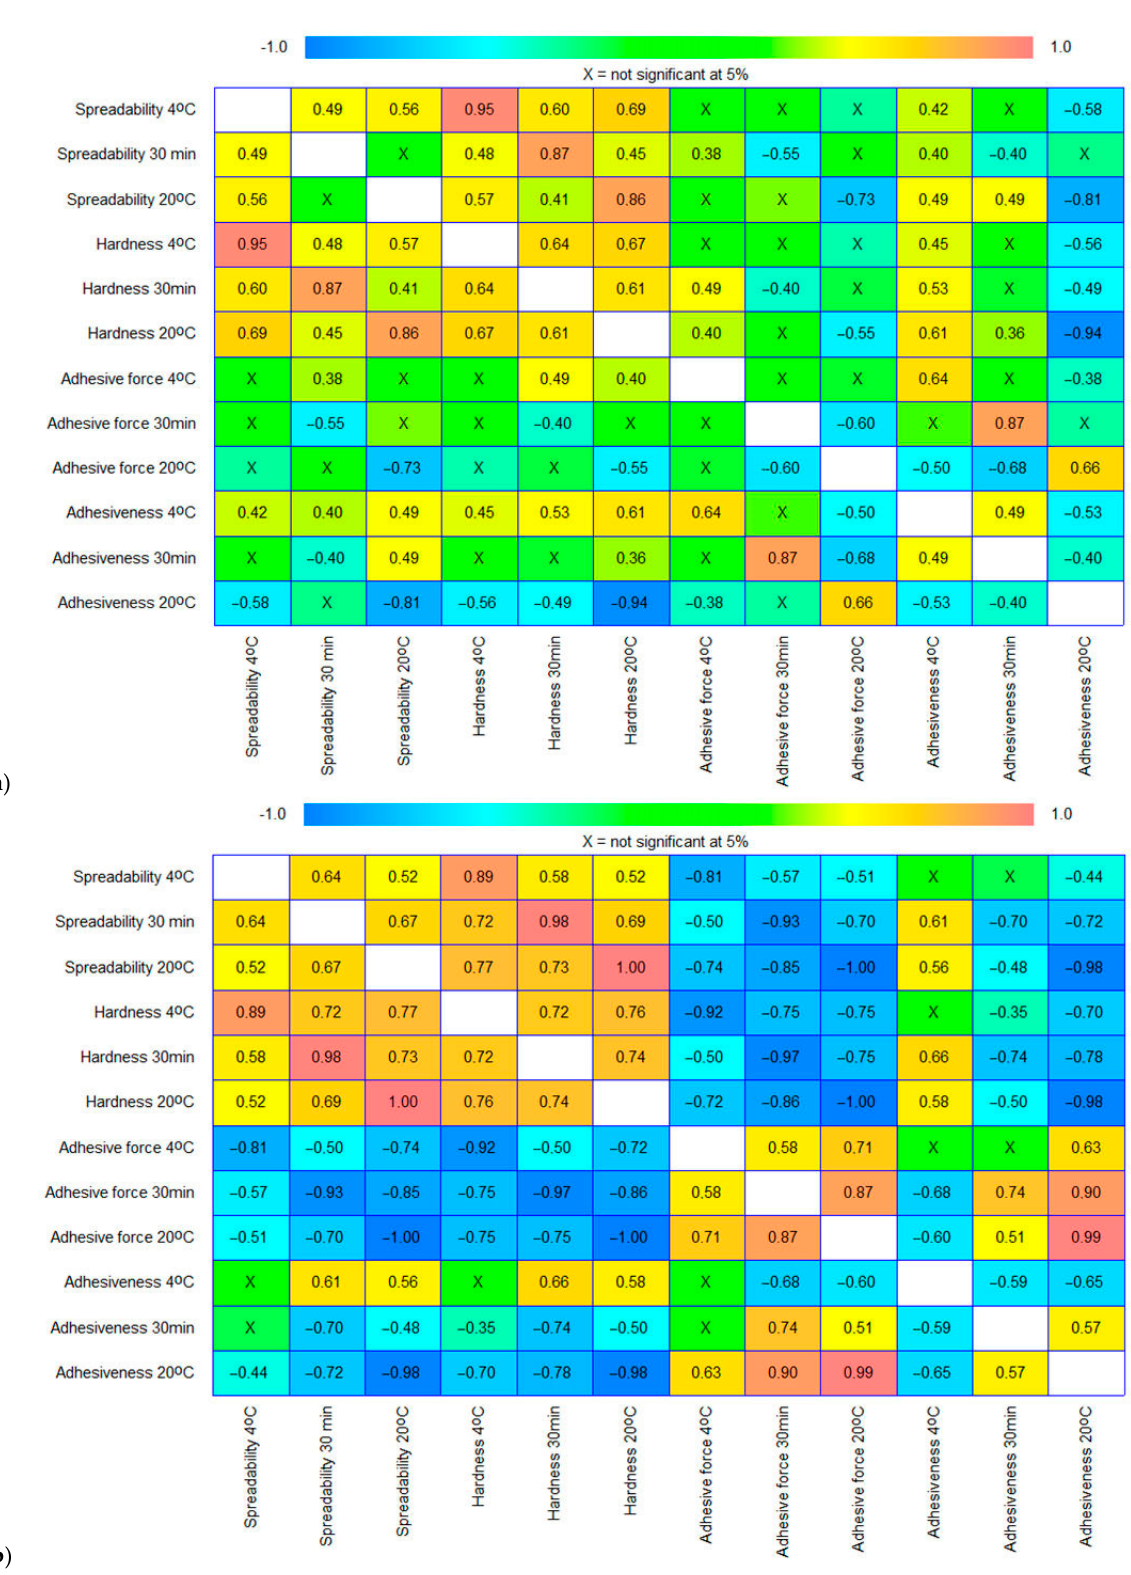
Figure 1. Graphs of correlation matrix showing the relationship between the spreadability, hardness, adhesive force and adhesiveness of butter and butter substitute samples ( a ) and butter substitute samples alone ( b ) measured at different temperatures (with a confidence level of